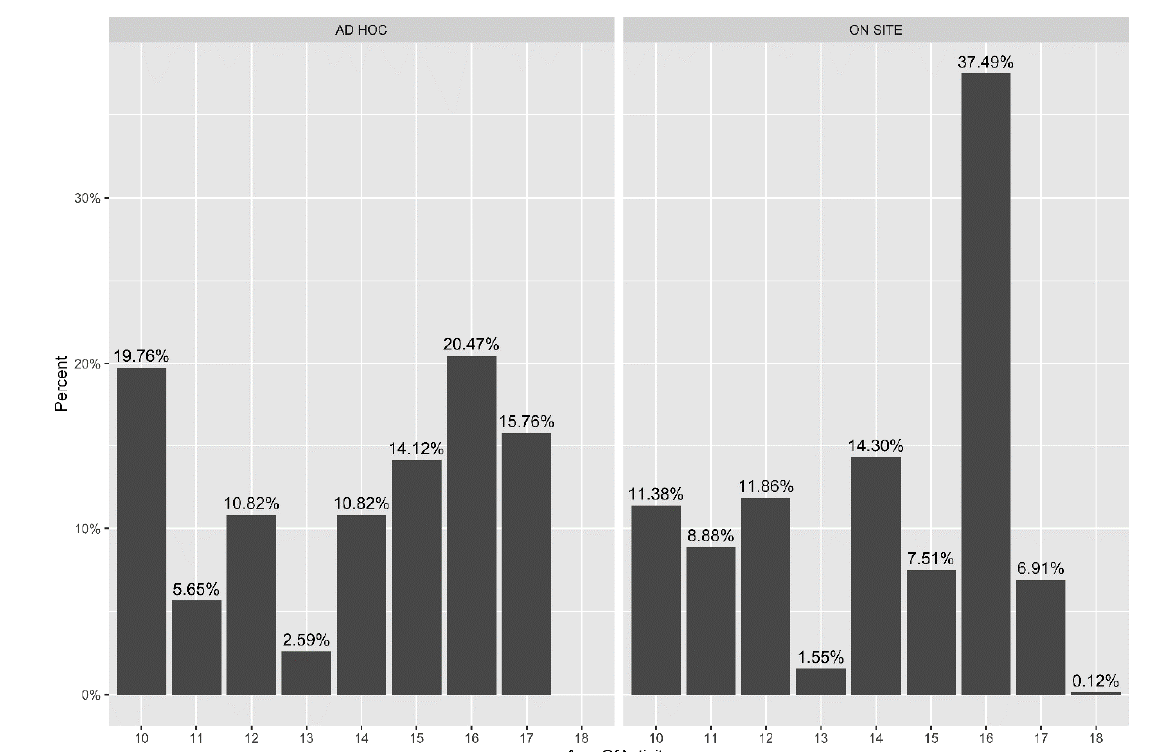
Figure 1. Comparison between area of activity at ad hoc and on-site ambulatory. Area of activity: 10 Administrative; 11 Newborn; 12 Pediatric; 13 General Surgery; 14 Specialist Surgery; 15 General Medicine; 16 Specialist Medicine; 17 Intensive Care Unit; 18 Missing Data.